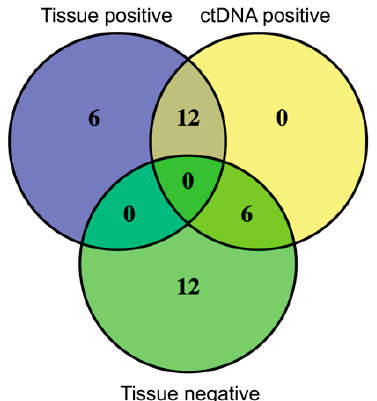
Figure 5. Concordance between tissue and ctDNA driver mutations for stage IV melanoma patients ( n = 36). Values shown represent number of patients.